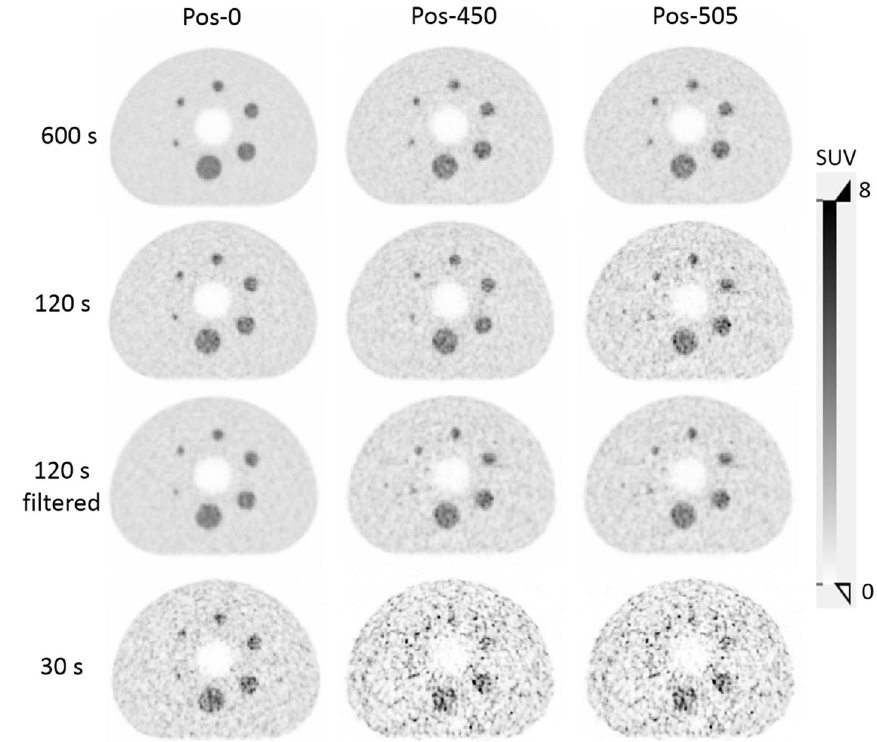
Fig. 6 Central slice of the IQ phantom measurements with a SBR of 4:1 at different axial positions for the different acquisition durations. Further, representations including also the 15 s data can be found in the Additional File 2